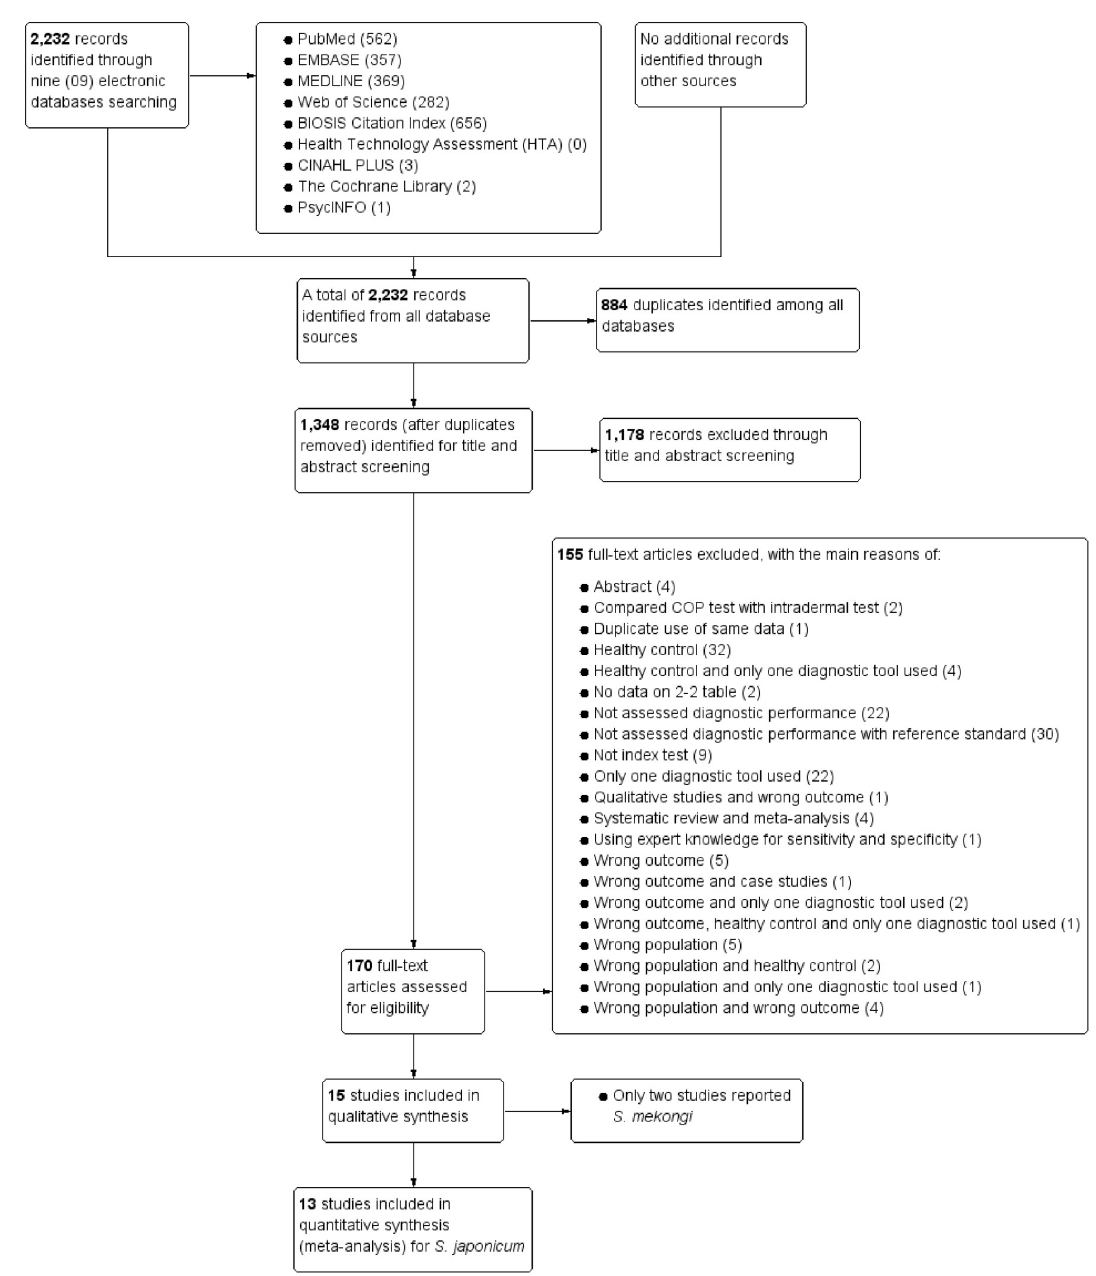
Fig 1. PRISMA flowchart of study